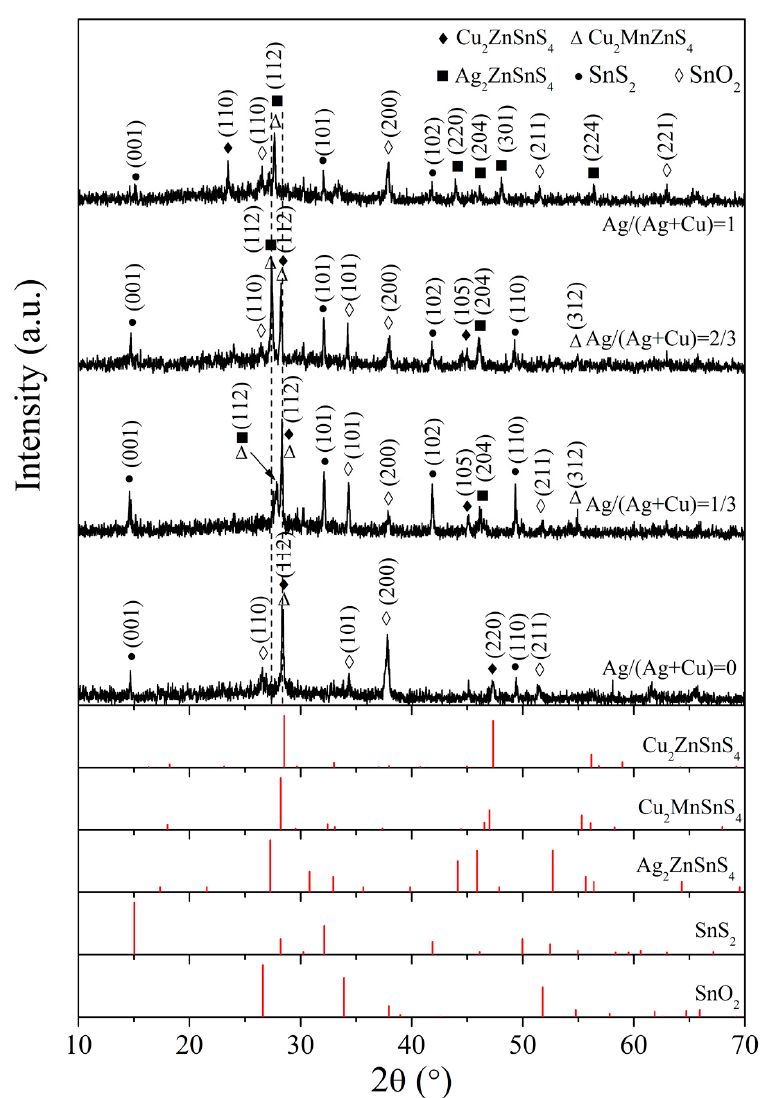
Figure 2. XRD patterns of Ag and Mn co-doped Cu 2 ZnSnS 4 thin films with different Ag/(Ag + Cu) ratios and the standard XRD peaks for Cu 2 ZnSnS 4 , Cu 2 MnSnS 4 , Ag 2 ZnSnS 4 , SnS 2 , and SnO 2 .